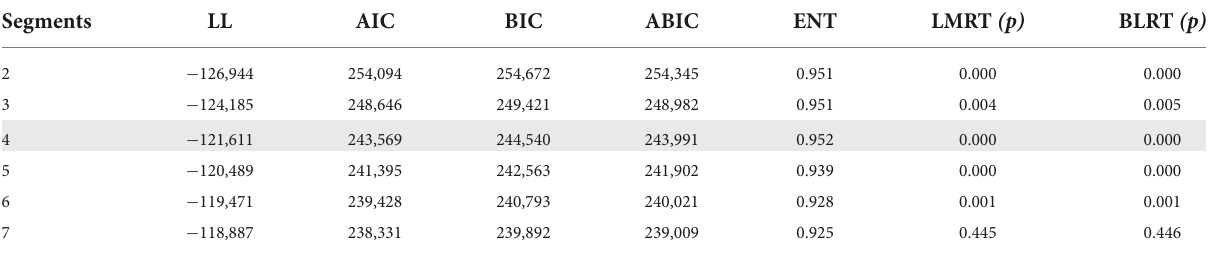
TABLE 3 Comparison of fit indices for determining the number of classes.